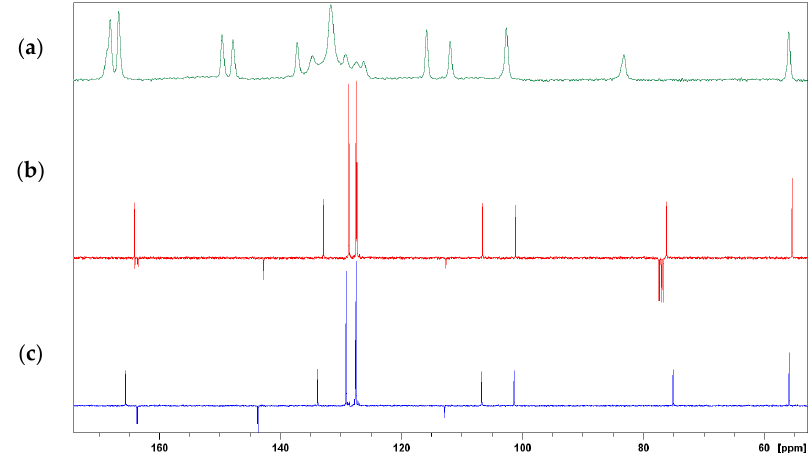
Figure D8. A comparison of solid state 13 C CP-MAS spectrum of mvanadpm ( a ) with solution state